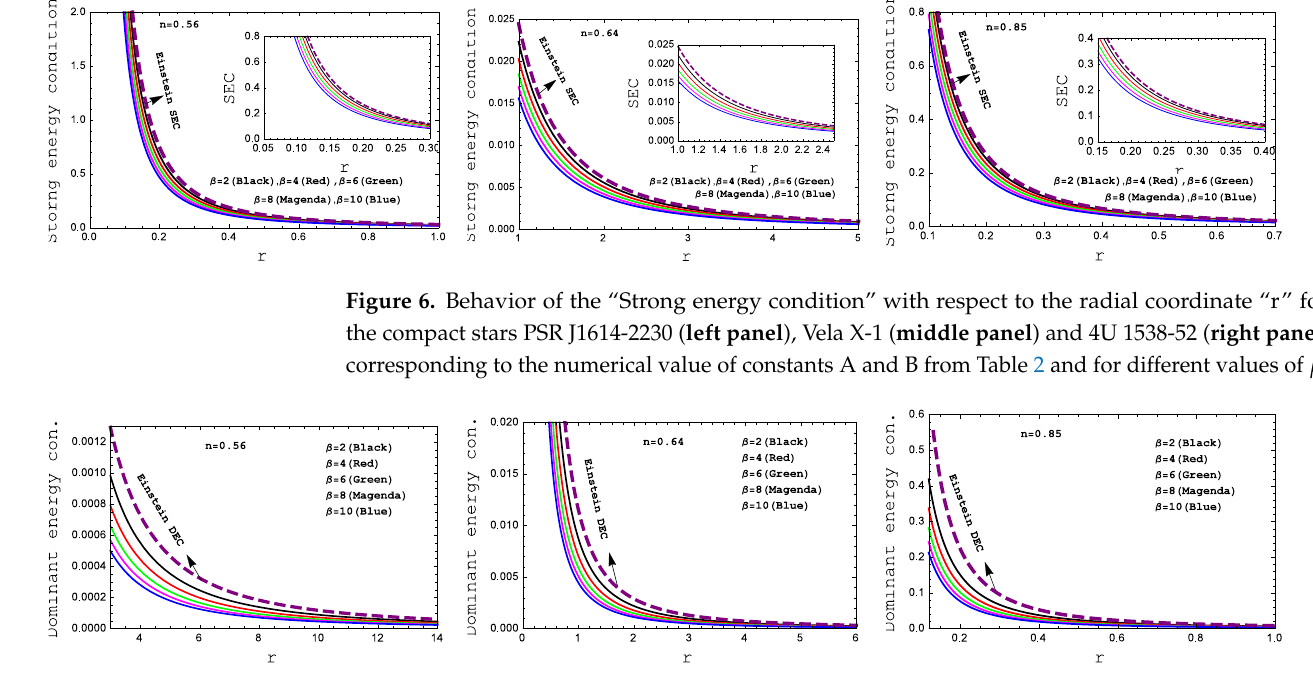
Figure 7. Behavior of the “Dominant energy condition” with respect to the radial coordinate “r” for the compact stars PSR J1614-2230 ( left panel ), Vela X-1 ( middle panel ) and 4U 1538-52 ( right panel ) corresponding to the numerical value of constants A and B from Table 2 and for different values of β